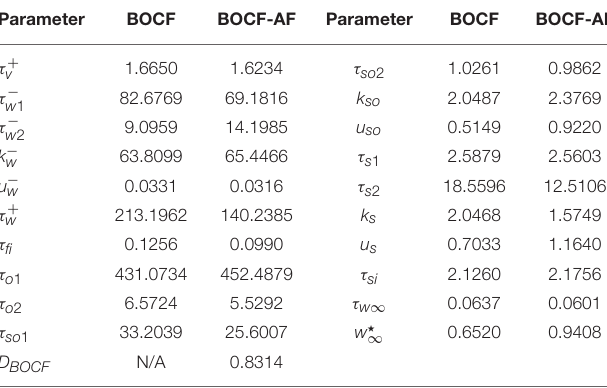
TABLE 1 | Parameter values of Bueno-Orovio Cherry Fenton